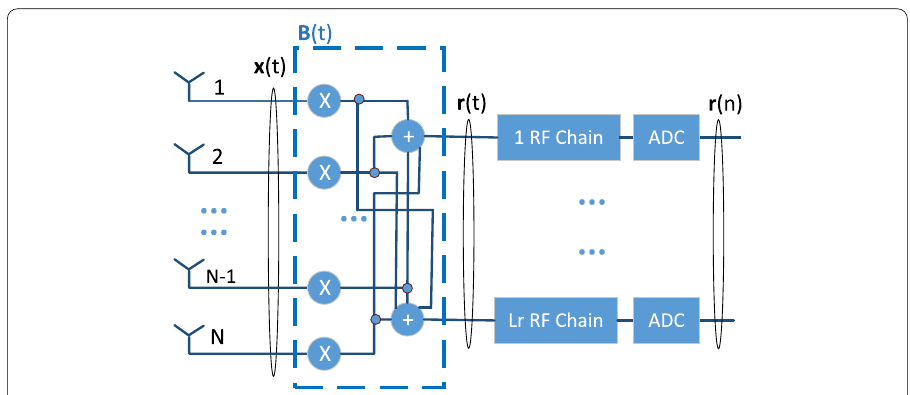
Fig. 3 The receiver in the fully connected hybrid